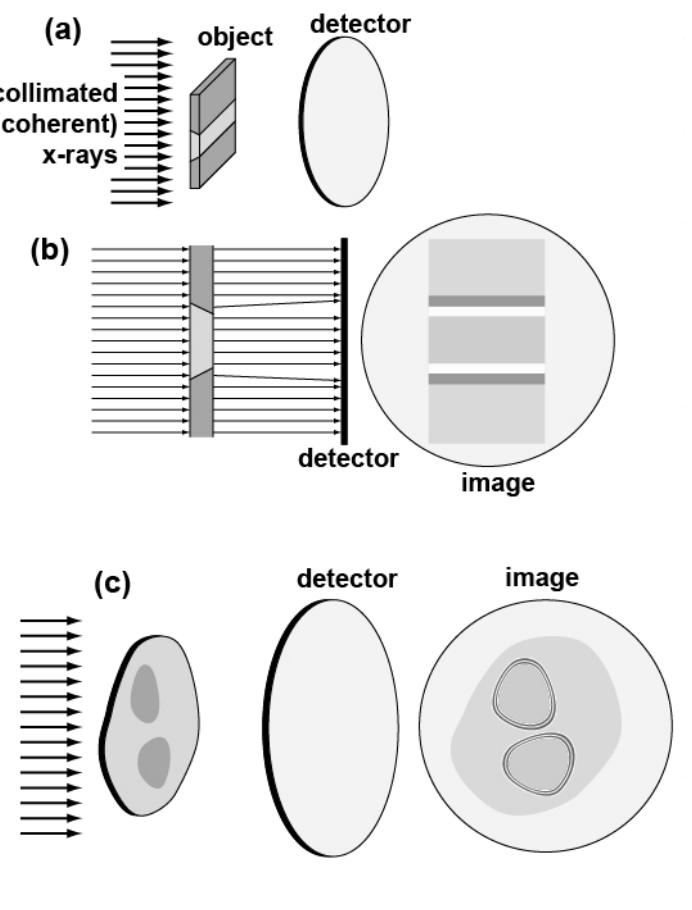
Figure 14. Schematic explanation of the edge enhancement mechanisms in radiological images that are produced by coherent x-rays and are due to the real part of the complex refractive index. (a) and (b) show edge enhancement due to refraction and (c) a Fresnel- like diffraction mechanism [23,